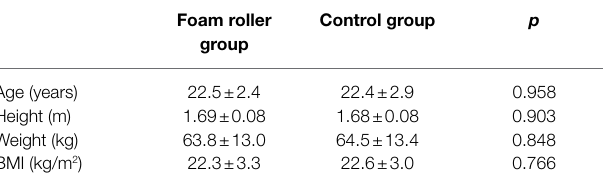
TABLE 1 | The characteristics of the subjects. Foam roller